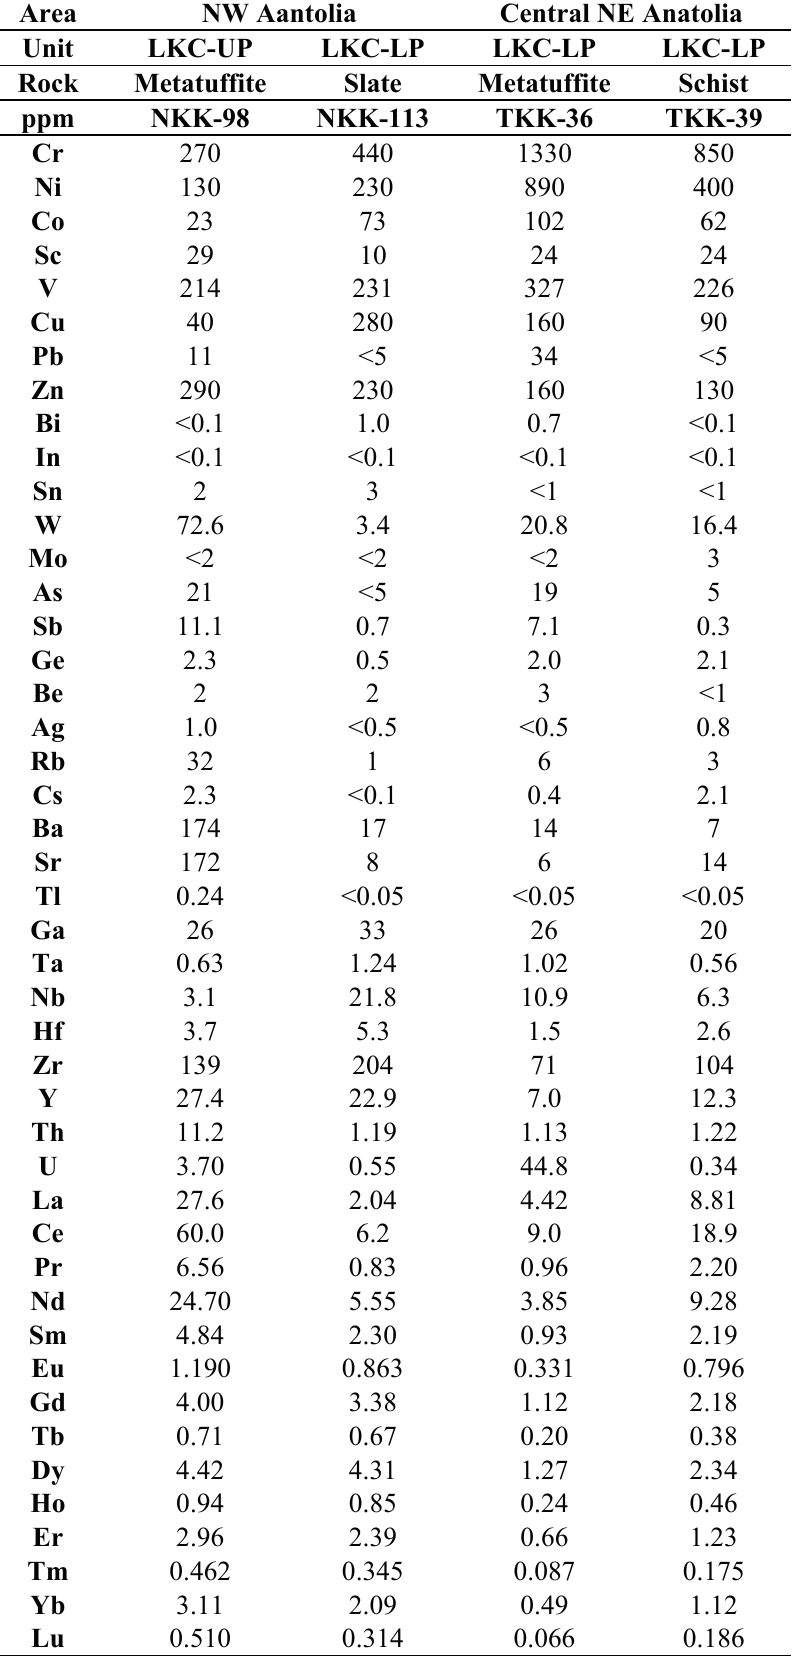
Table 7. Trace element composition of chlorite minerals in the Karakaya Complex units (<: Concentrations are below the detection